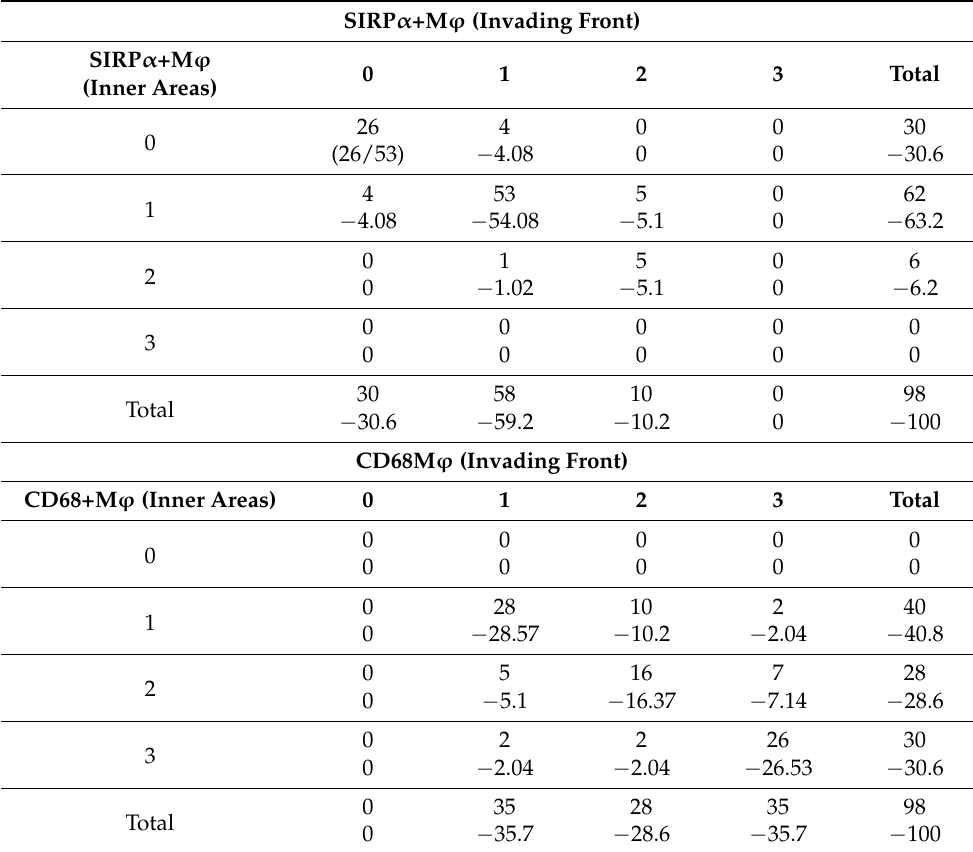
Table 1. Distribution of the score of infiltration of tumor stroma by SIRP α and CD68 expressing macrophages (invading front vs. inner tumor areas). Numbers in brackets aside from numbers refer to the percentage of scored cases in the total of 98 patients. SIRP α +M ϕ (Invading